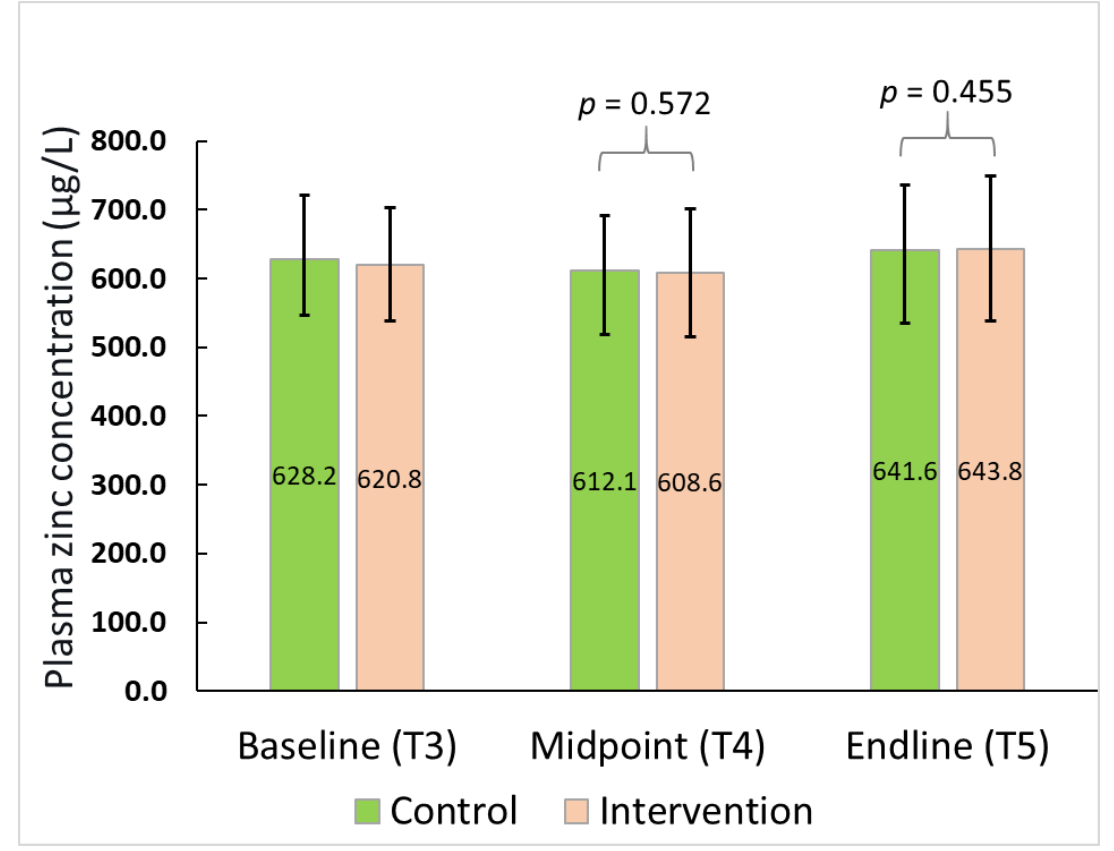
Figure 3. Plasma zinc concentration for the participants over time.